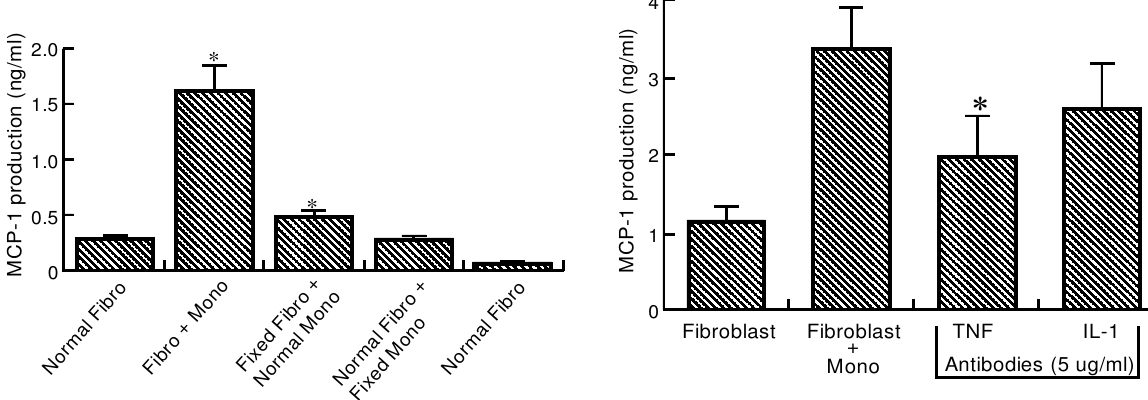
FIG. 2. MCP-1 production during fibroblast–monocyte inter- action. Enriched monocyte populations were layered onto fibroblast monolayers. Either the monocytes or the fibroblast were fixed with 4% paraformaldehyde (5min) and MCP-1 levels were determined in 2h culture supernatants. MCP-1 was produced by both cell populations. Data represents mean ± SE from two different experiments. P <0.05